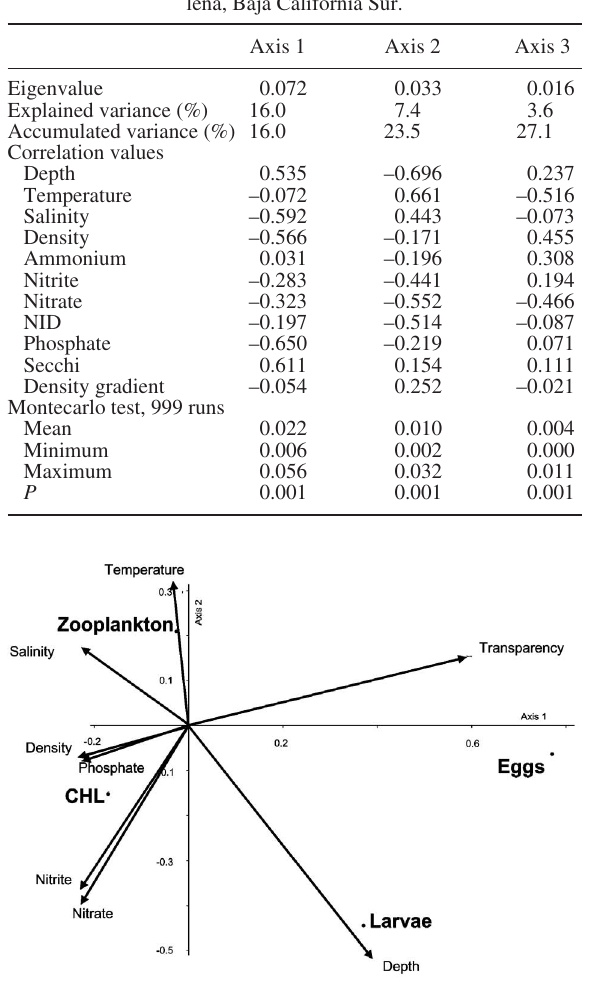
Fig . 6. – CCA ordination diagram using Sardinops sagax egg and larval abundance , c hlorophyll a concentration and zooplankton volume (points) during winter and early spring 2005-2009 in Bahía Magdalena, Baja California Sur. Arrows represent significant ex- planatory factors; arrowheads indicate the positive direction for the different variables (matrix 92